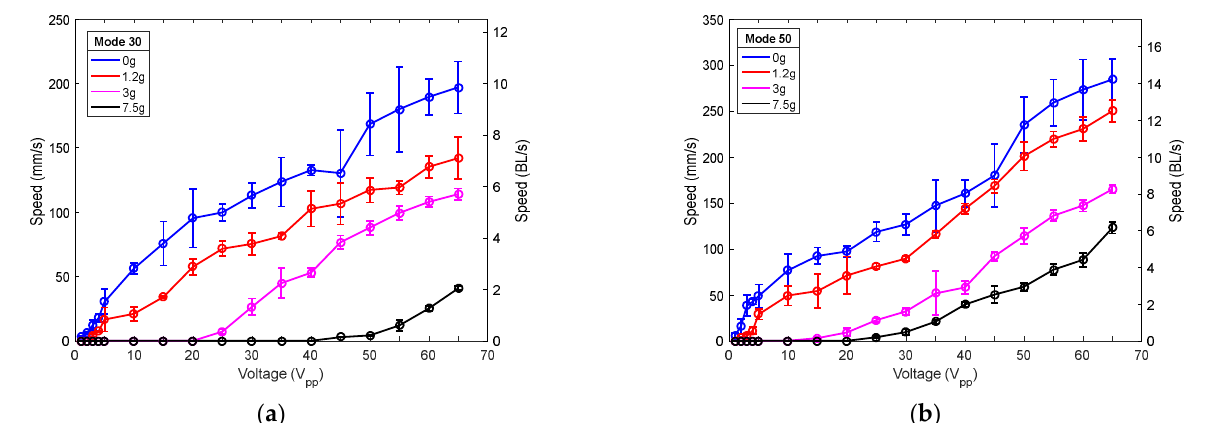
Figure 10. Speed of ( a ) the (30) mode-actuated robot and ( b ) the (50) mode-actuated robot, versus applied voltage for different masses: no load (blue), 1.2 g (red), 3 g (pink), and 7.5 g (black).